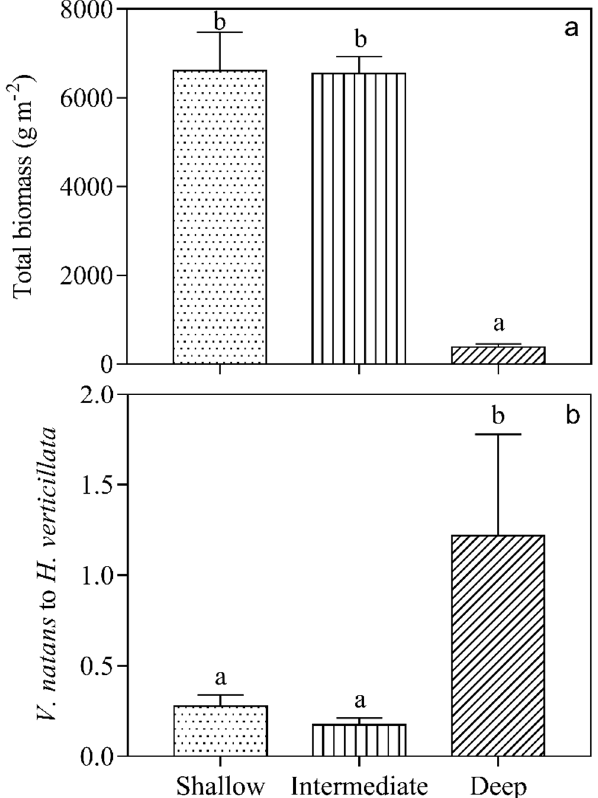
Figure 3. Comparisons of ( a ) total macrophyte biomass (g m − 2 ) and ( b ) biomass ratio of V. natans to H. verticillata among the three water depth groups. Values represent mean ± SD (n = 4). Means with different letters are significantly different ( p < 0.05). Table 2. One-way ANOVA results of the growth and morphological indices of both submerged macrophytes among different water depths.